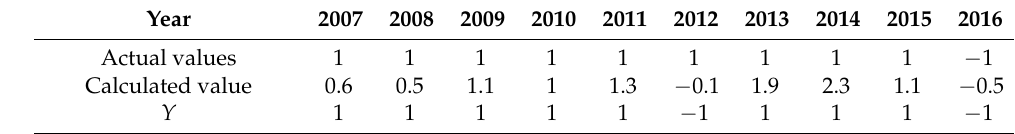
Table 2. Calculated values of model and actual values of typhoon precipitation events in validated